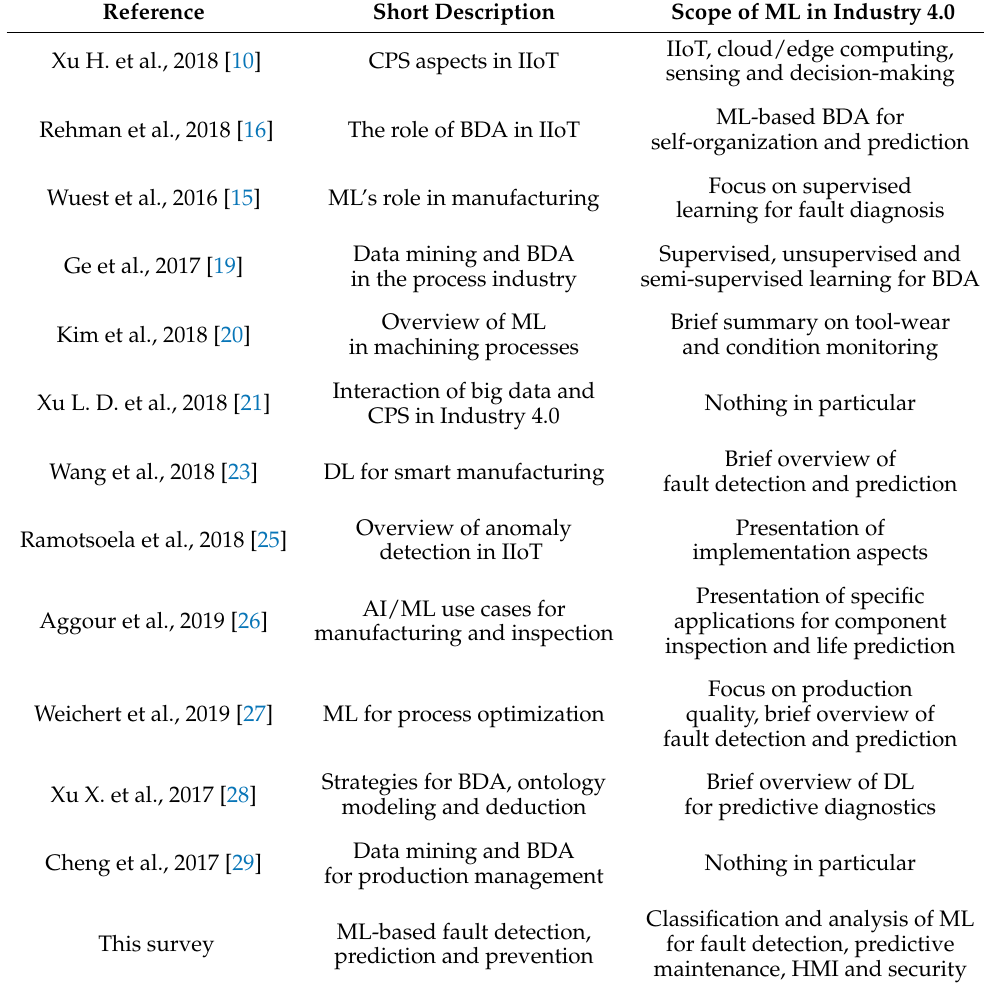
Table 1. Relevant surveys and tutorials on artificial intelligence (AI)/ML and Industry